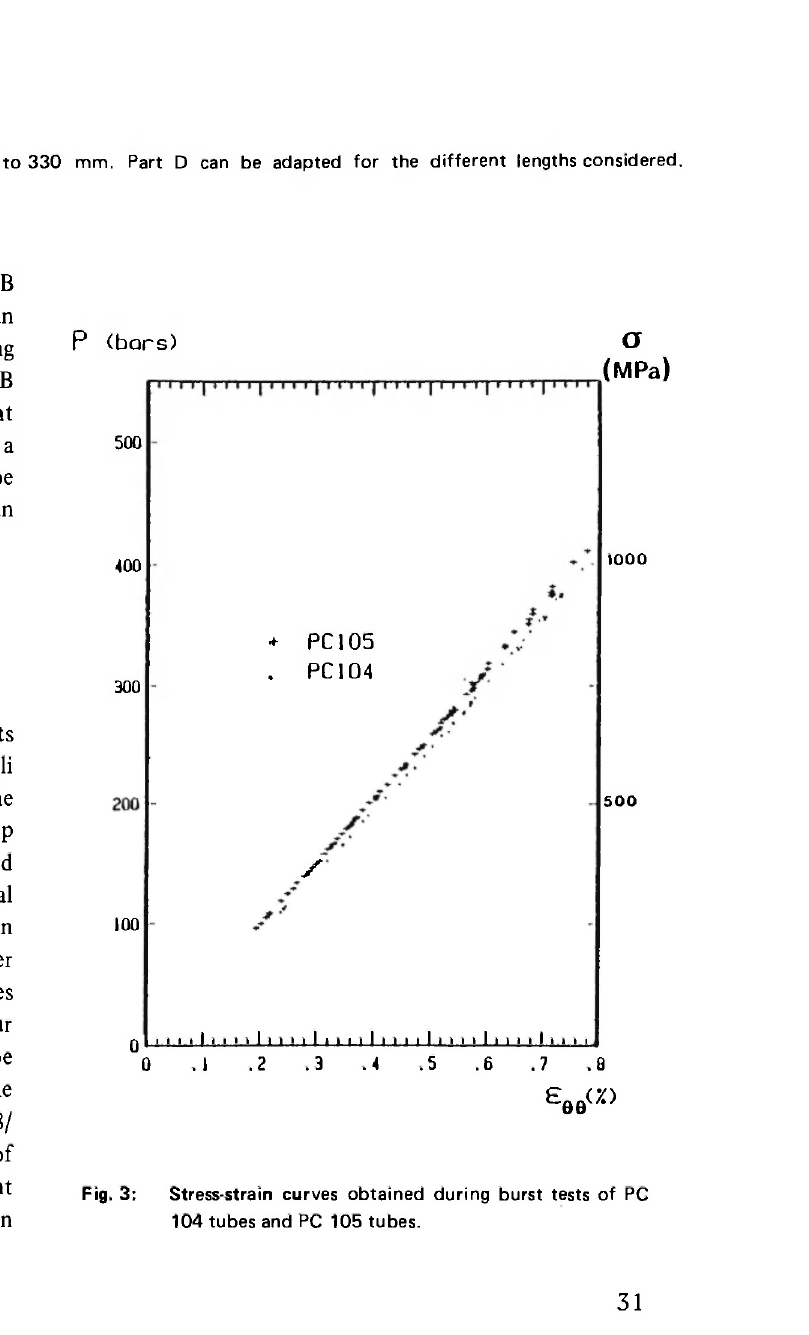
Fig. 2: Test apparatus for pressuring a tube of length equal to 330 mm. Part D can be adapted for the different lengths considered.